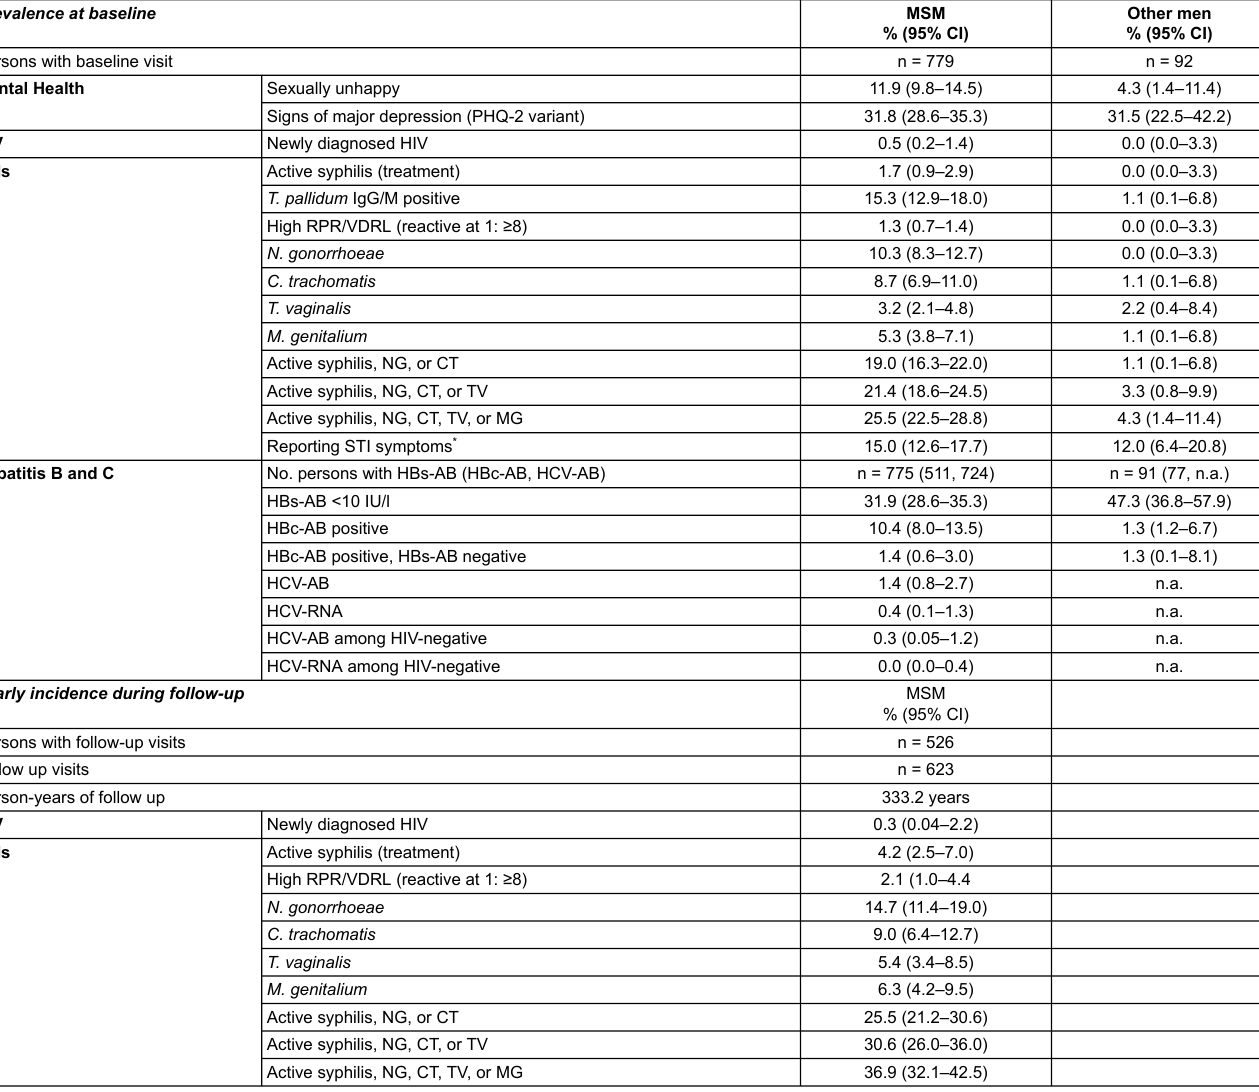
Table 2: Clinical outcomes. Mental health, HIV, STIs, Hepatitis B and C, percentages with 95% confidence intervals. Prevalence at